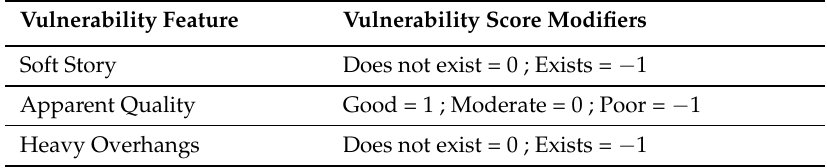
Table 3. Vulnerability score modifiers for concrete structures